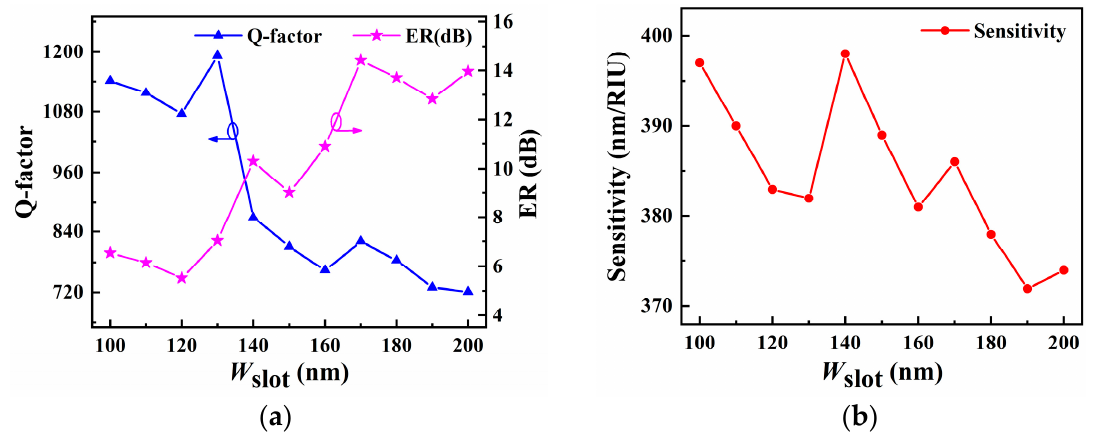
Figure 4. ( a ) Dependence of Q -factor and ER of SMRR on W slot at resonance wavelength. ( b ) Sensi- tivity as a function of W slot at the resonance